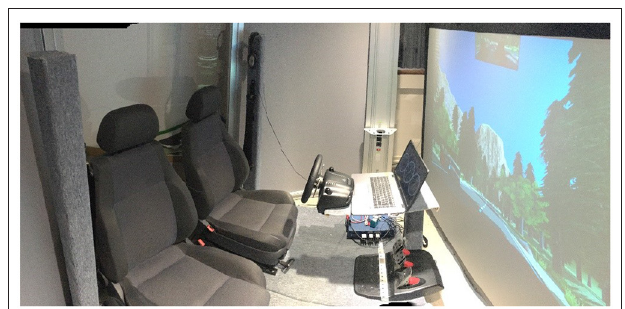
FIGURE 2 | The driving